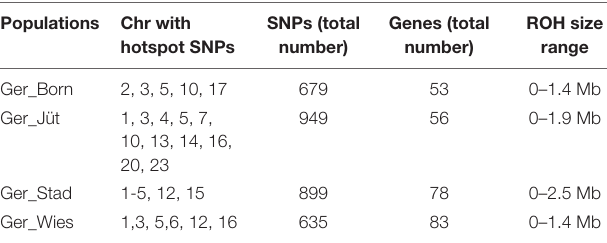
TABLE 5 | Number of significant SNPs in ROH regions, genomic distribution, and genes mapped in the same regions for each German buffalo population analyzed in this work (Chr: